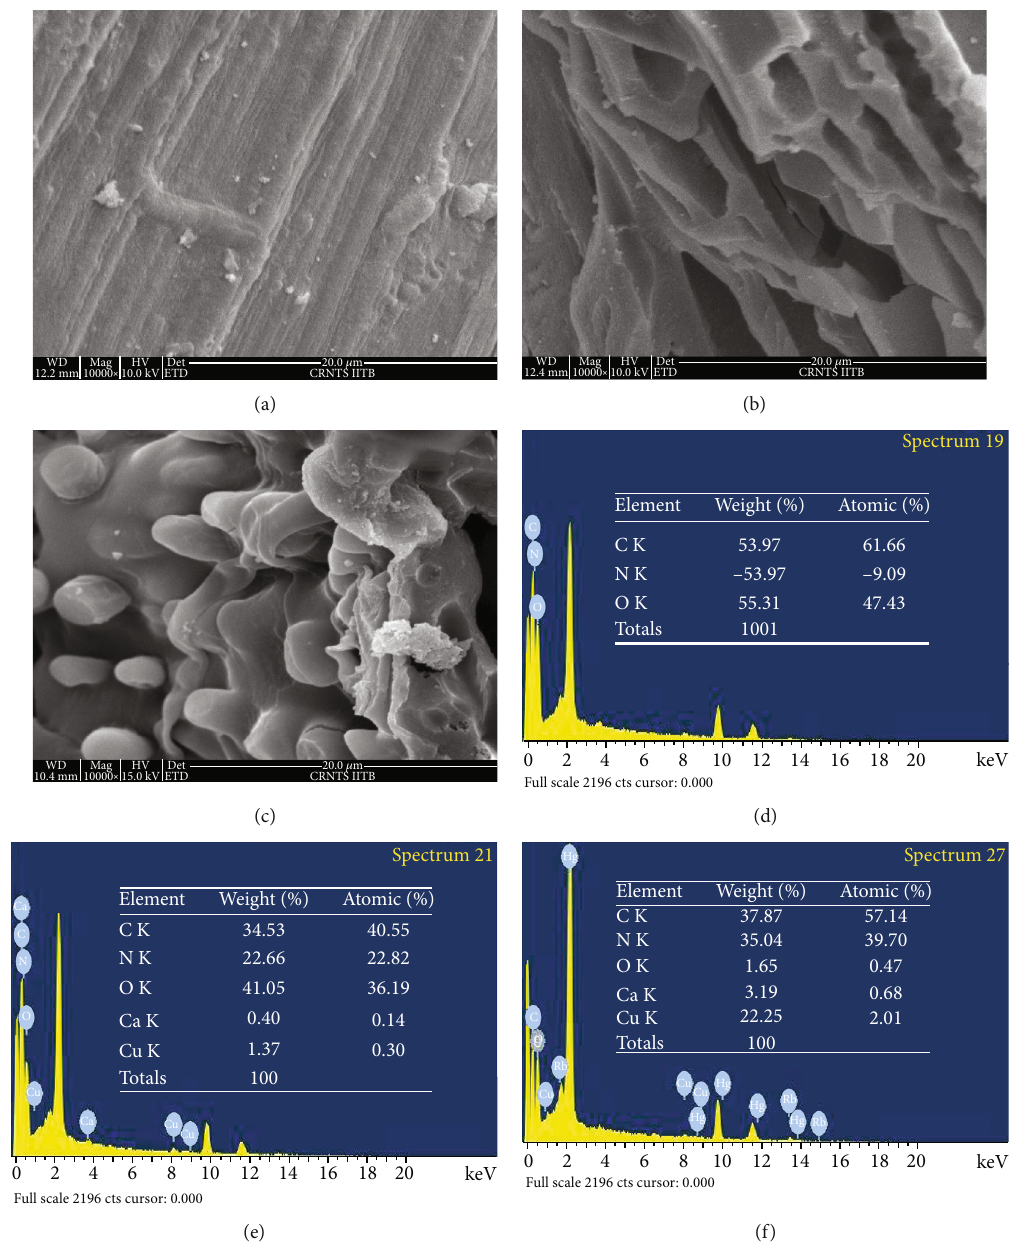
Figure 6: ESEM mages for (a) ACR, (b) ACMAS, and (c) ACMAS after dye adsorption and XEDS images for (d) ACR, (e) ACMAS, and (f) ACMAS after dye